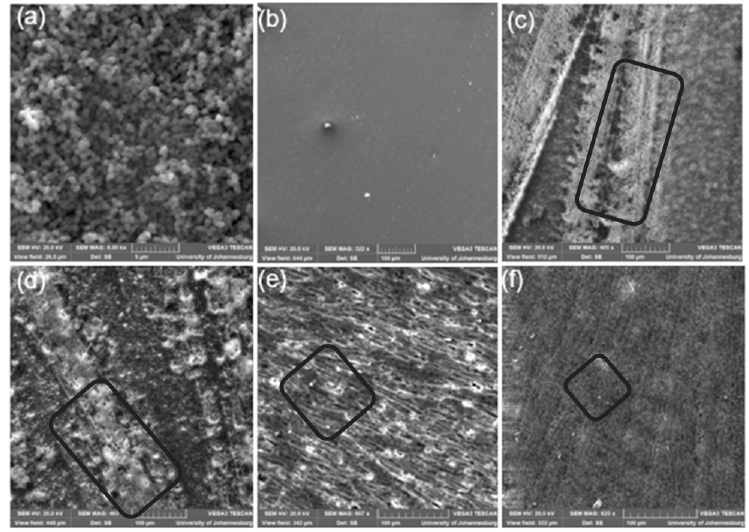
Figure 7. SEM images of ZIF-8 ( a ), PPO ( b ), ImPPO ( c ), ImPPO/1% ZIF-8 ( d ), ImPPO/3% ZIF-8 ( e ), and ImPPO/5% ZIF-8 ( f ) composites